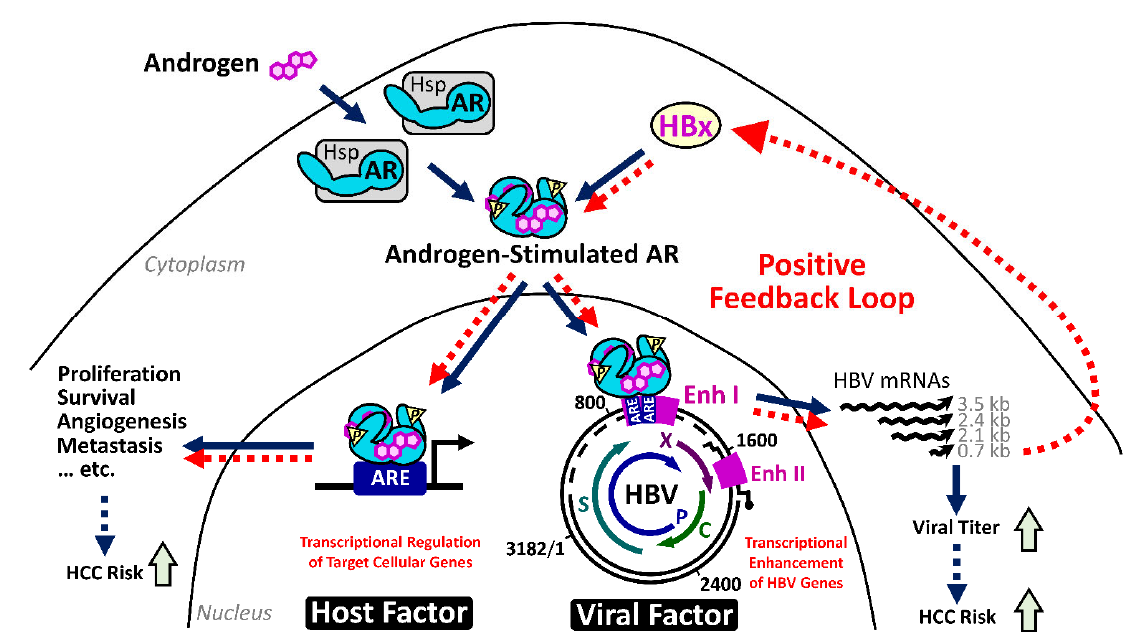
Figure 1. Illustration of the positive feedback loop between HBx and AR for promotion of HBV-induced hepatocarcino- genesis in male CHB patients. In male HBV carriers with chronic infection, HBx enhances the transcriptional activity of androgen-activated AR, which recognizes the androgen-responsive element (ARE) motifs within viral enhancer I (Enh I), thus reinforcing overall HBV gene expression including HBx (the right part). On the other hand, the HBx-activated AR could aberrantly stimulate downstream expression of proto-oncogenes, which facilitate cell proliferation and survival in the carcinogenic process. This positive feedback circuitry may simultaneously elevate serum HBV titer and activate host genes with carcinogenic potentials in infected hepatocytes, leading to the elevated risk of HCC development in male CHB patients.